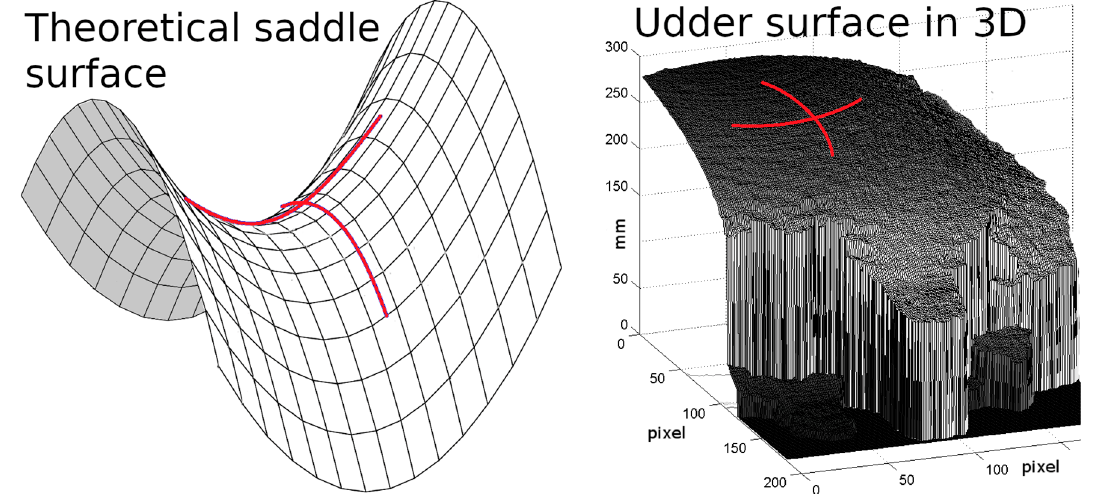
Figure 3. Exemplary visualisation of principal curvatures (red) in a point on a theoretical saddle surface ( left ) and the surface of an udder as measured by the Kinect ( right ). The mean curvature is the average of the principal curvatures, but can also be calculated from the gradient and the Hessian matrix in the respective surface point (Equation